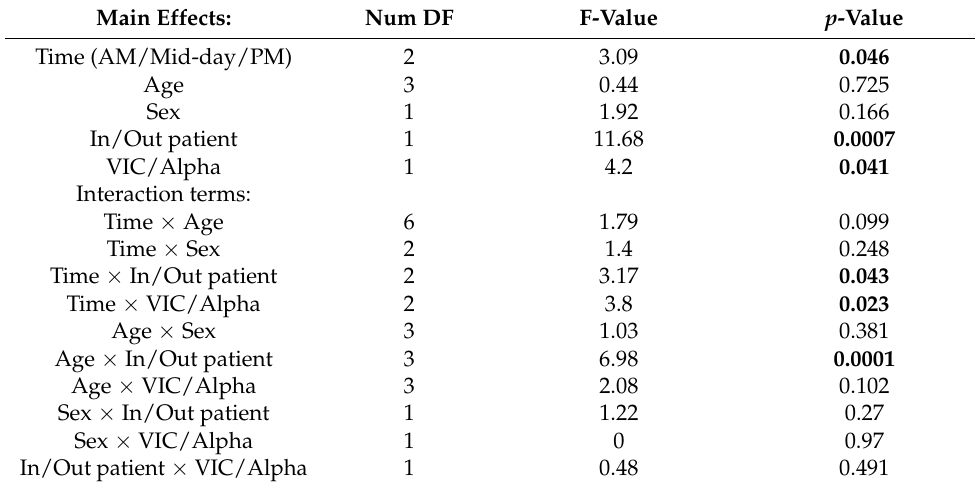
Table 3. Analyses with three time groups.